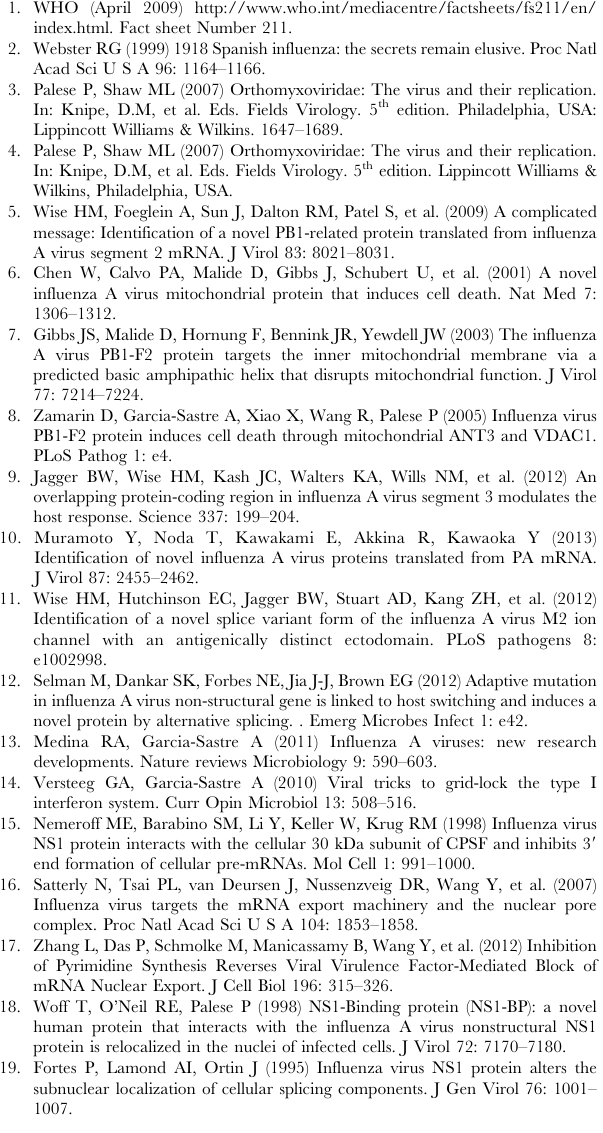
Table S1 Identification of NS1-BP binding proteins by mass spectrometry. HeLa cell lysates were immunoprecipitat- ed with control IgG or NS1-BP antibodies in the absence of RNase. Interacting proteins were resolved by SDS-PAGE and identified by mass spectrometry. The gel lane was divided into eight segments from molecular weight 250 kDa to 35 kDa, and the top hits of each segment are listed in the